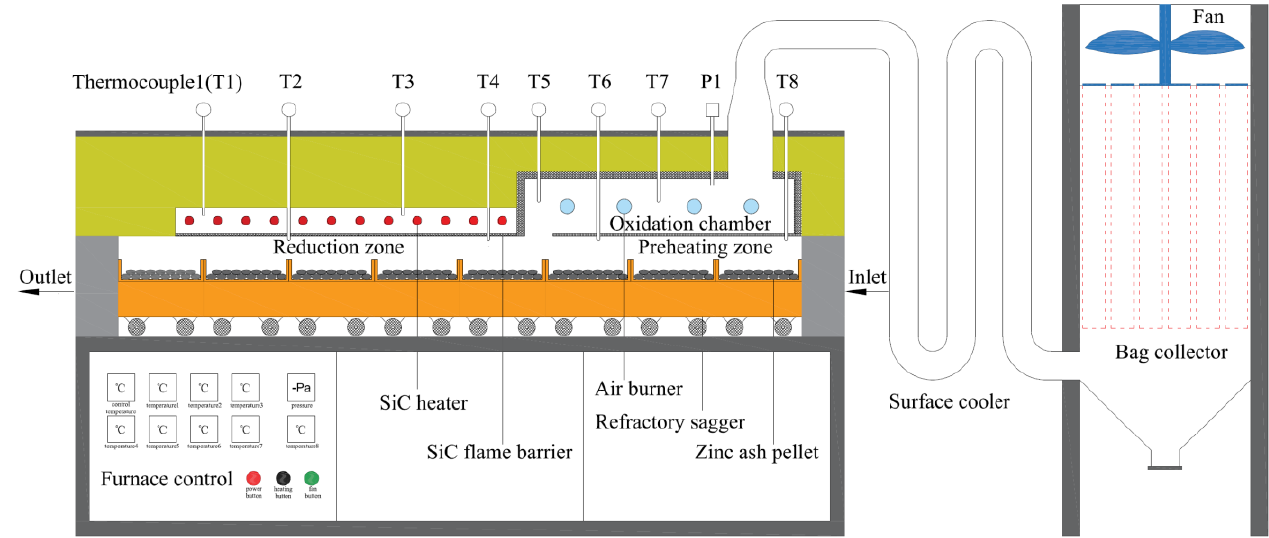
Figure 3. Experimental installation diagram of carbon thermal reduction of zinc ash.